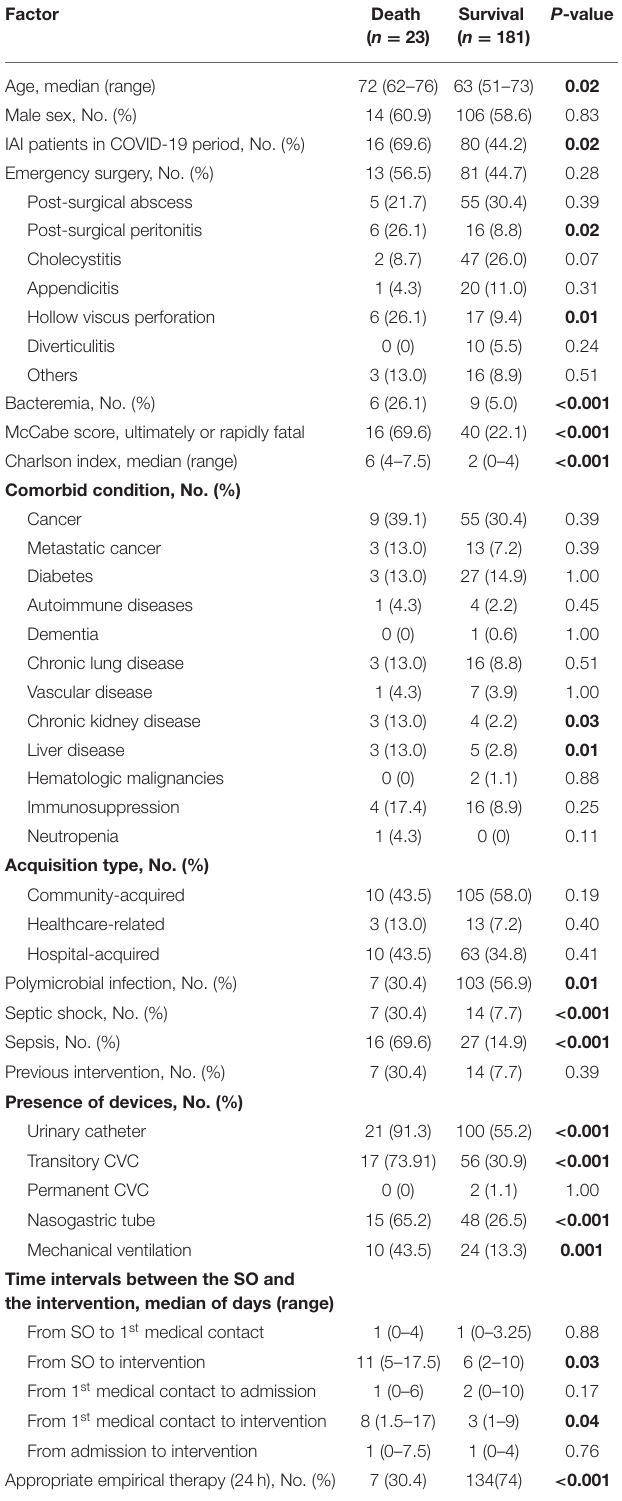
TABLE 2 | Univariate analysis of the factors related to death in a combined cohort of the pre-COVID-19 pandemic cohort and the COVID-19 pandemic cohort.